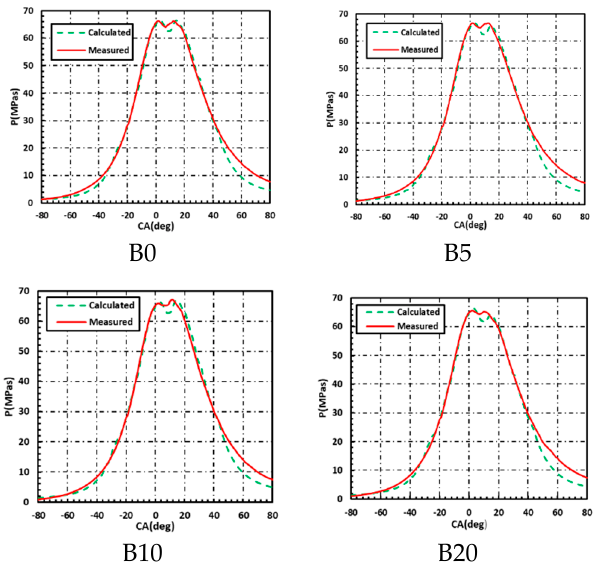
Figure 12. Comparison of measured and calculated CP curves for all fuels at 1400 rpm and 100% load.